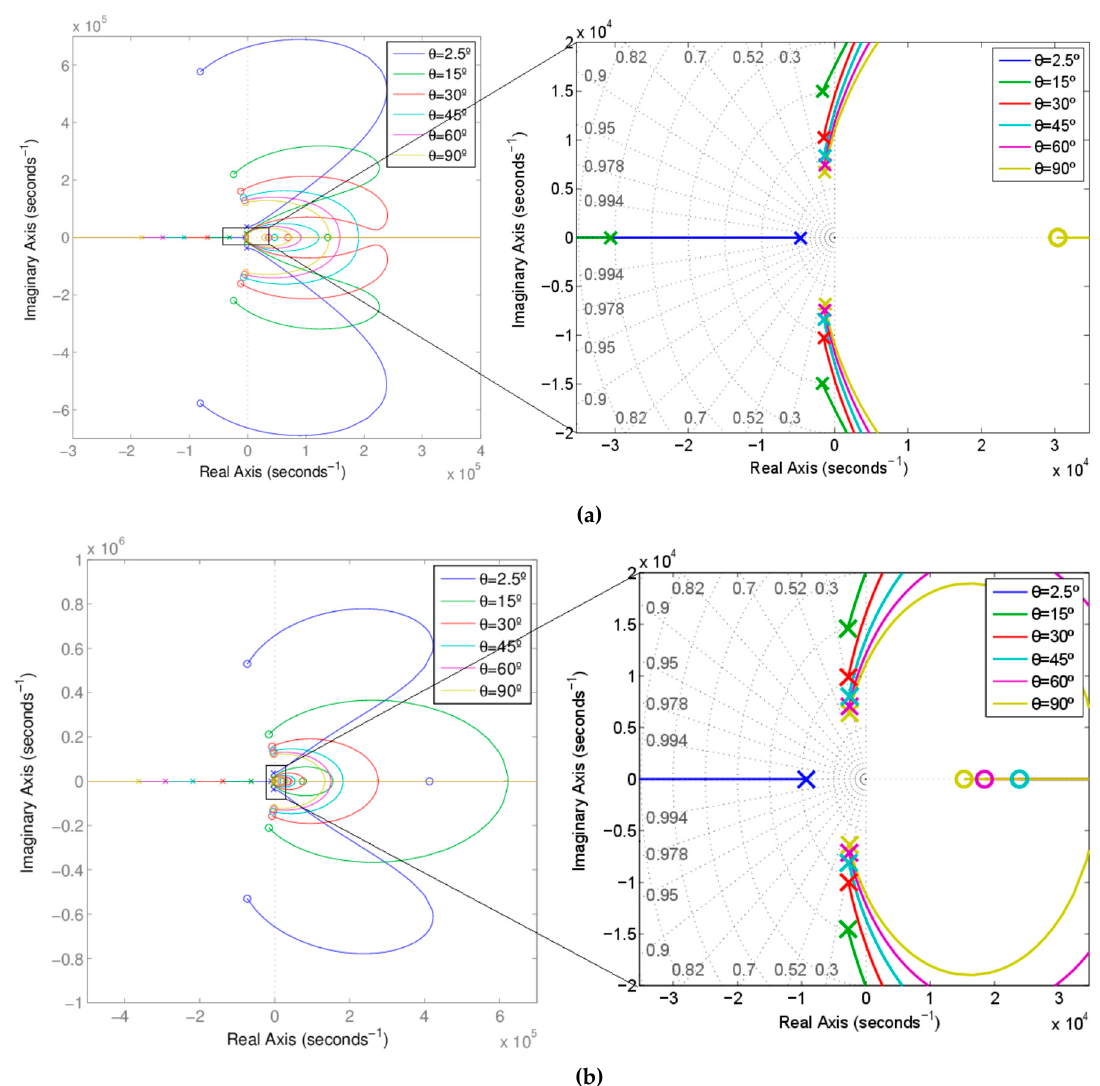
Figure 14. Root locus of 𝑔(cid:3548) (cid:3038) (cid:4666)𝑠(cid:4667) for ( a ) 100 W, ( R = 484 Ω ), Figure 14. Root locus of for ( a ) 100 W, ( R = 484 Ω ), ( b ) for 200 W, ( R = 242 Ω ( b ) for 200 W, ( R = 242 Ω ).